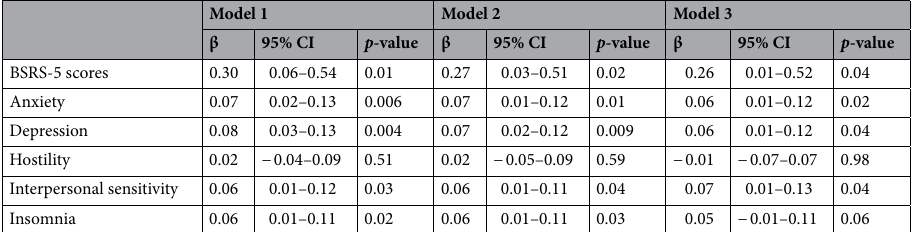
Table 2. Multivariable liner regression analysis for decayed tooth numbers with BSRS-5 score. Data are presented as odds ratios and 95% confidence intervals (CI) using multiple logistic regression analysis for. Model 1: age, sex and education levels adjustments. Model 2: age, sex, education levels, body weight categories and physical activity adjustments. Model 3: age, sex, education levels, body weight categories, physical activity, high-density lipoprotein, fasting glucose, triglycerides and cigarette smoking adjustments. BSRS-5 brief symptom rating scale-5.